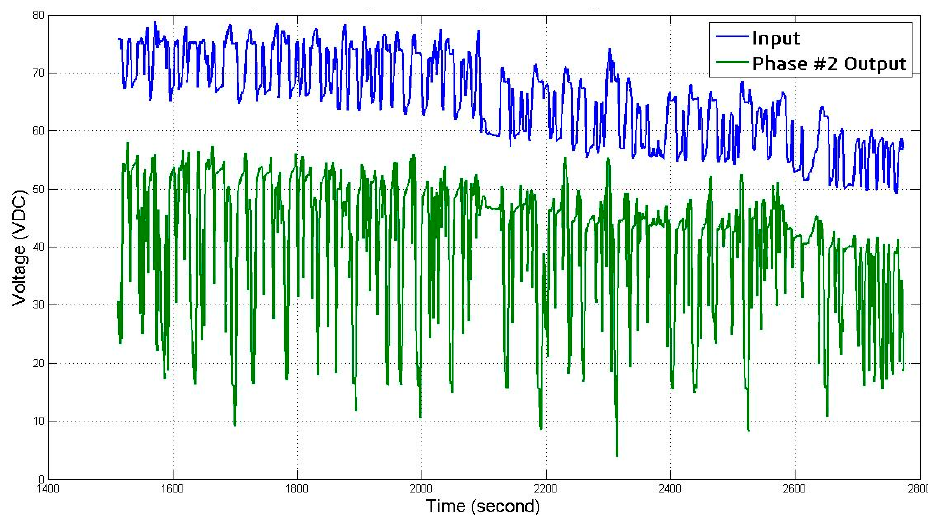
Figure 10. Input voltage vs. output voltage—phase #2.